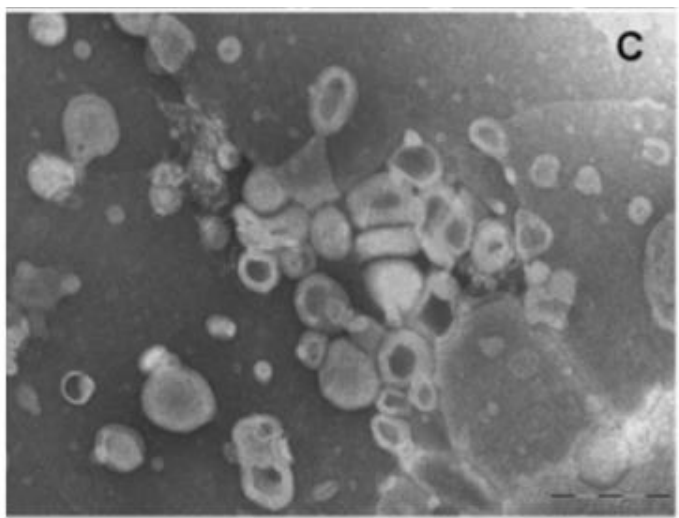
Figure 3. TE micrographs of diclofenac sodium loaded in PL90H-based glycerosomes containing 20% glycerol, scale bar 200 nm. Reproduced from Reference [40] with permission.